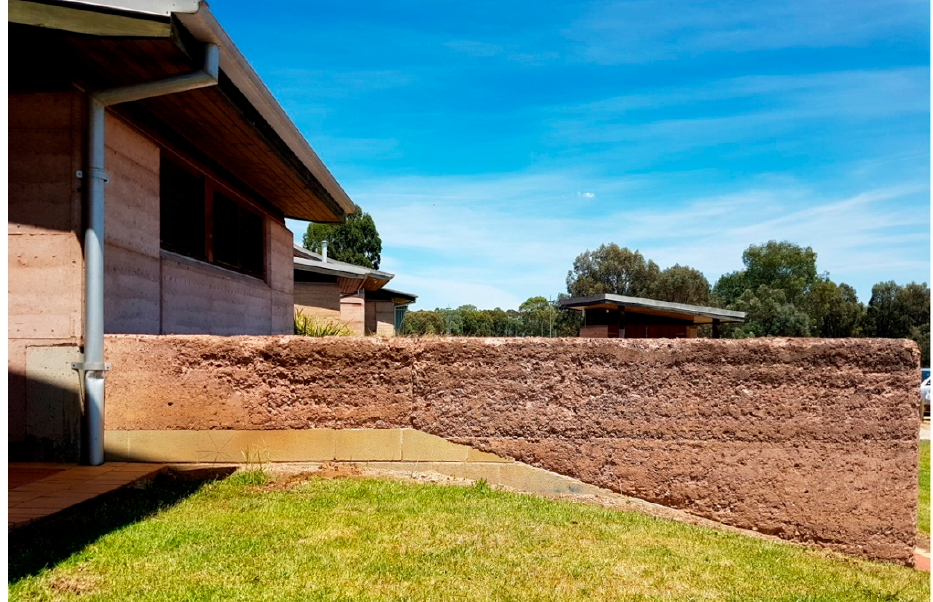
Figure 10. Wing wall 3 seen from the east. Note the linear decay at left, indicating different layers of compaction.